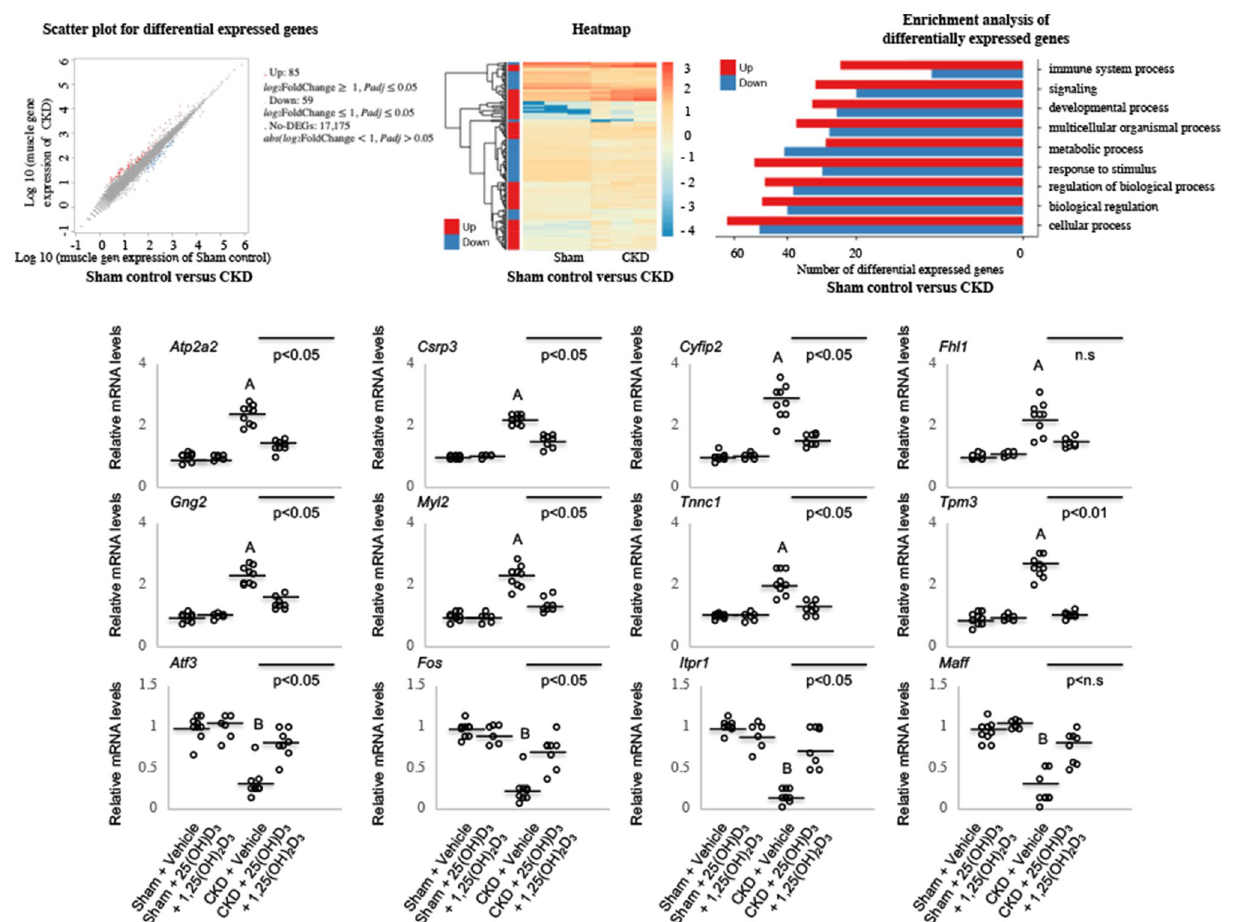
Figure 7. RNAseq analysis of gastrocnemius muscle. Summary of the number of differentially expressed genes (DEG) between CKD and sham control mice. We performed 5/6 nephrectomy and sham operation in 12-month old male C57BL/6J mice. Unbiased muscle RNAseq analyses were performed on the gastrocnemius muscle in 12-month old CKD mice versus age-appropriate control mice. Hierarchical clustering heatmap of DEG in CKD mice versus sham control mice. Gene ontology enrichment analysis for those DEG. To study the effects of vitamin D repletion in CKD mice, we further performed quantitative real-time PCR on gastrocnemius muscle from 4 groups of younger mice (3 months of age at sacrifice), i.e., Sham + Vehicle, Sham + 25(OH)D 3 + 1,25(OH) 2 D 3 , CKD + Vehicle as well as CKD + 25(OH)D 3 + 1,25(OH) 2 D 3 to determine the relative quantity of each targeted gene. Final results were expressed in arbitrary units, with one unit being the mean mRNA level in Sham + Vehicle mice. Results are analyzed as in Fig.